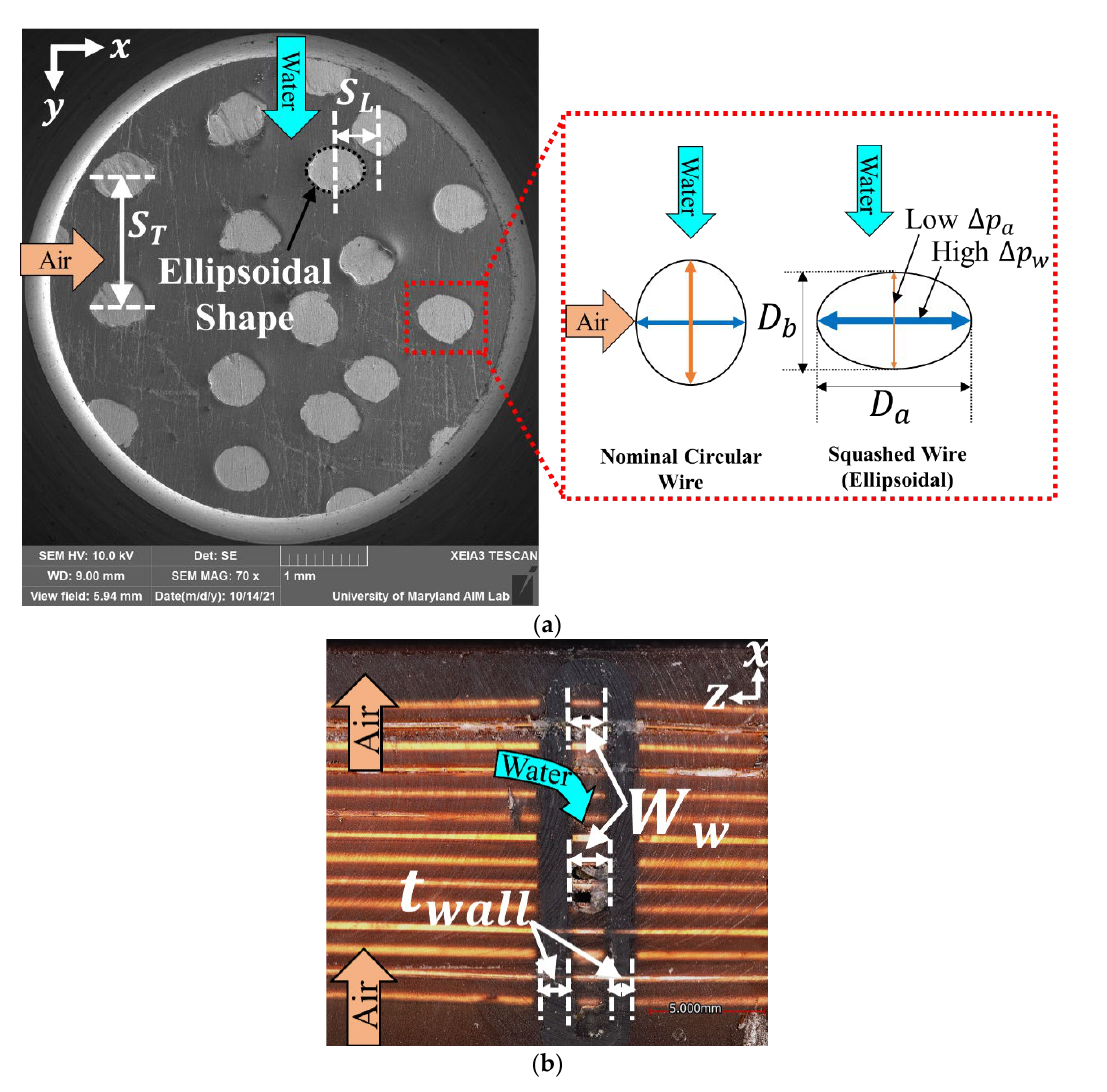
Figure 4. ( a ) SEM image for wire spacings and wire shape and ( b ) microscope image of varying water channel width. Table 4. Measured dimensions of iCMHX due to printing variabilities.